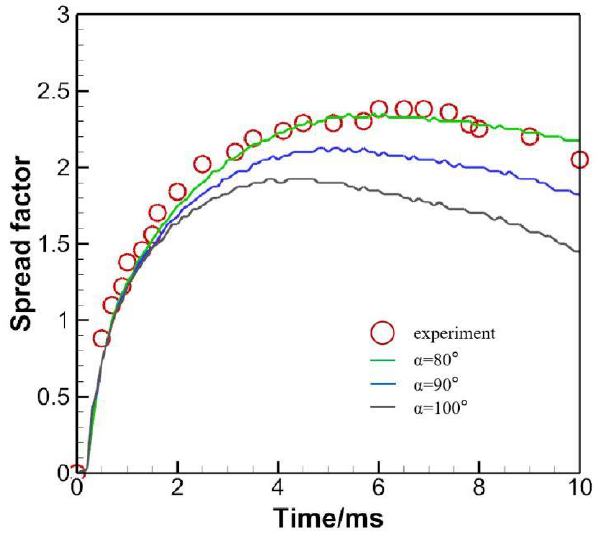
Figure 9. Contact angle effect on the oblique impact (45°) of water droplet.